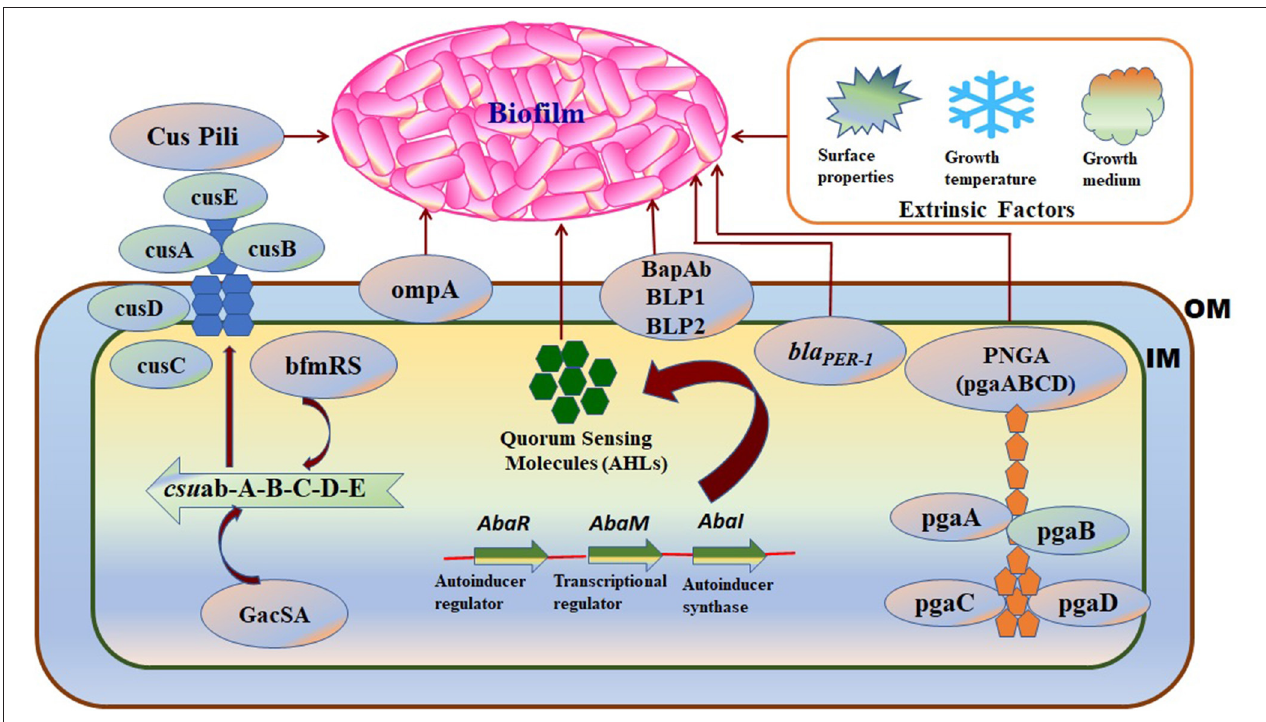
FIGURE 3 | A schematic diagram representing the intrinsic factors (genes) and the extrinsic factors that regulate biofilm formation in A. baumannii: OM, Outer membrane; IM, Inner membrane. Intrinsic factors: PNAG, Poly-(1–6)-N-acetylglucosamine; Csu, Chaperon/usher pilus system; OmpA, Outer membrane protein A; bla PER − 1, Beta-lactamase PER-1; bap-Ab, A. baumannii biofilm-associated protein; AHLs, N-acyl homoserine lactones; Extrinsic factors: surface properties, growth temperature, and growth